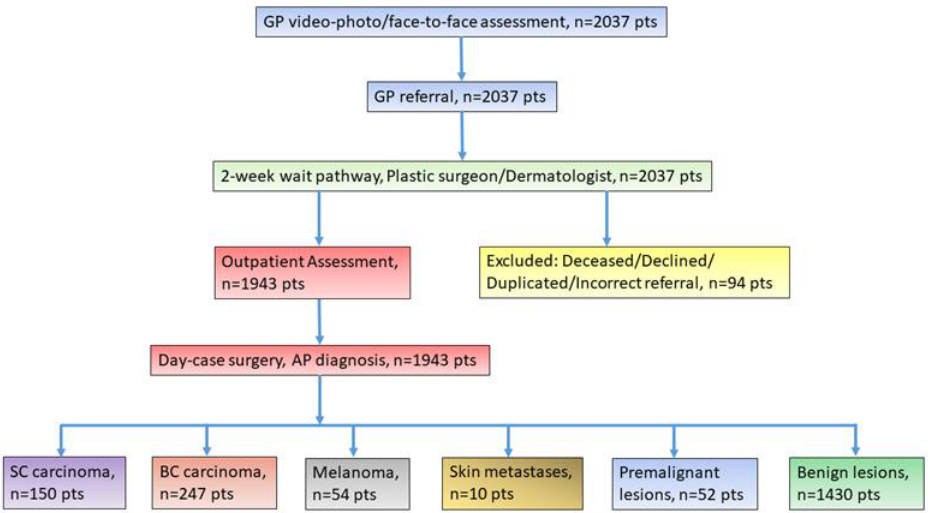
Figure 1. Flowchart of the study. GP, general practitioner; AP, anatomopathology; SC, squamous cell; BC, basal cell.